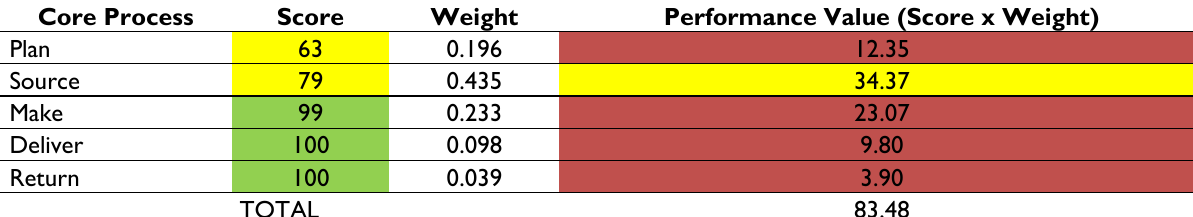
Table 14. Identify Strategies in KPIs